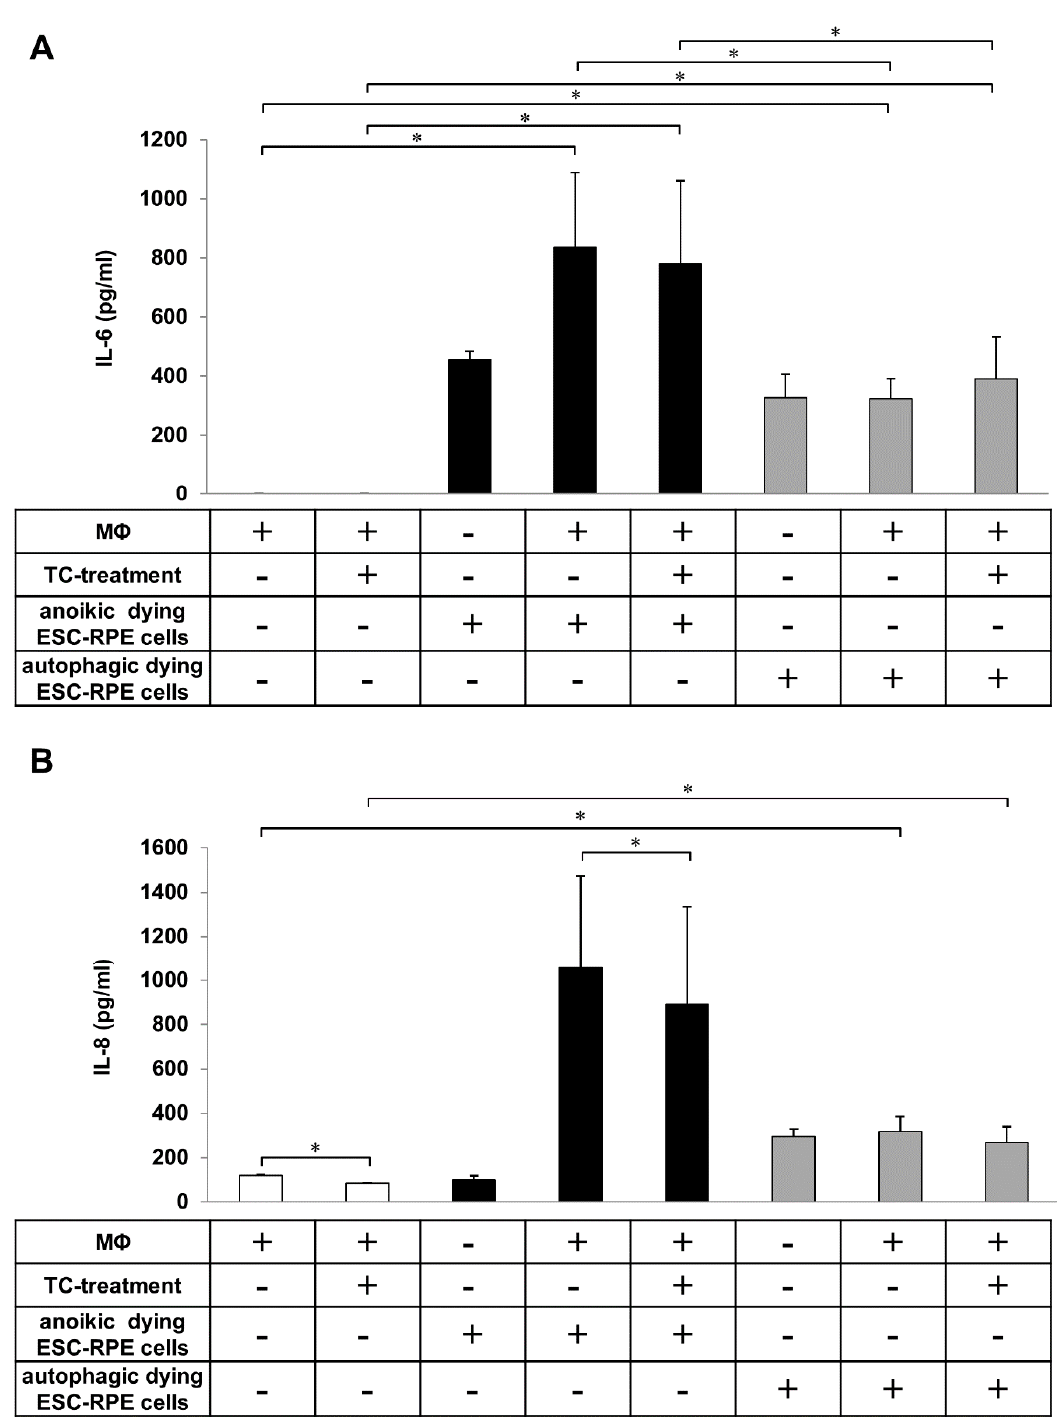
Figure 5. Determination of IL-6 and IL-8 release during the engulfment of anoikic and autophagy-associated dying hESC-RPE cells by macrophages. Anoikic dying hESC-RPE cells (left panels) and autophagy-associated dying hESC-RPE cells (right panels) were co-incubated with untreated and triamcinolone (TC)-treated (48 h, 1 µM) macrophages for 4 h and 8 h, respectively, then the supernatants were collected, and the level of secreted IL-6 ( A ) and IL-8 ( B ) cytokines were measured by ELISA. Bars represent the mean ± SD of 3 independent experiments, * p < 0.05.